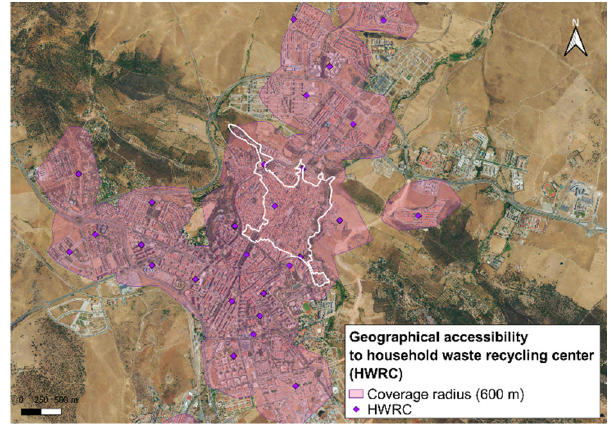
Figure 8. Map of geographical accessibility to household waste recycling centre (HWRC).